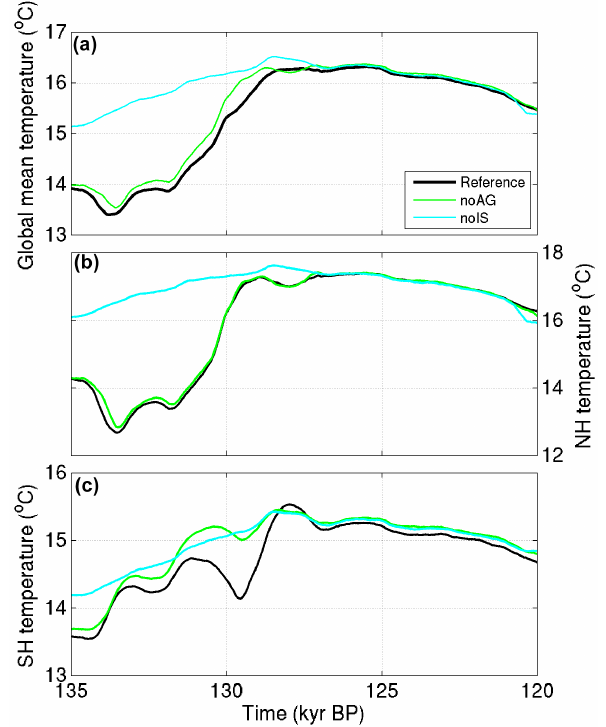
Figure 5. Evolution of global mean (a) , northern hemi- spheric (b) and southern (c) hemispheric mean surface temperature for experiments with different ice sheet forcing included. Curves are smoothed with a running mean of 200 years for better comparison.